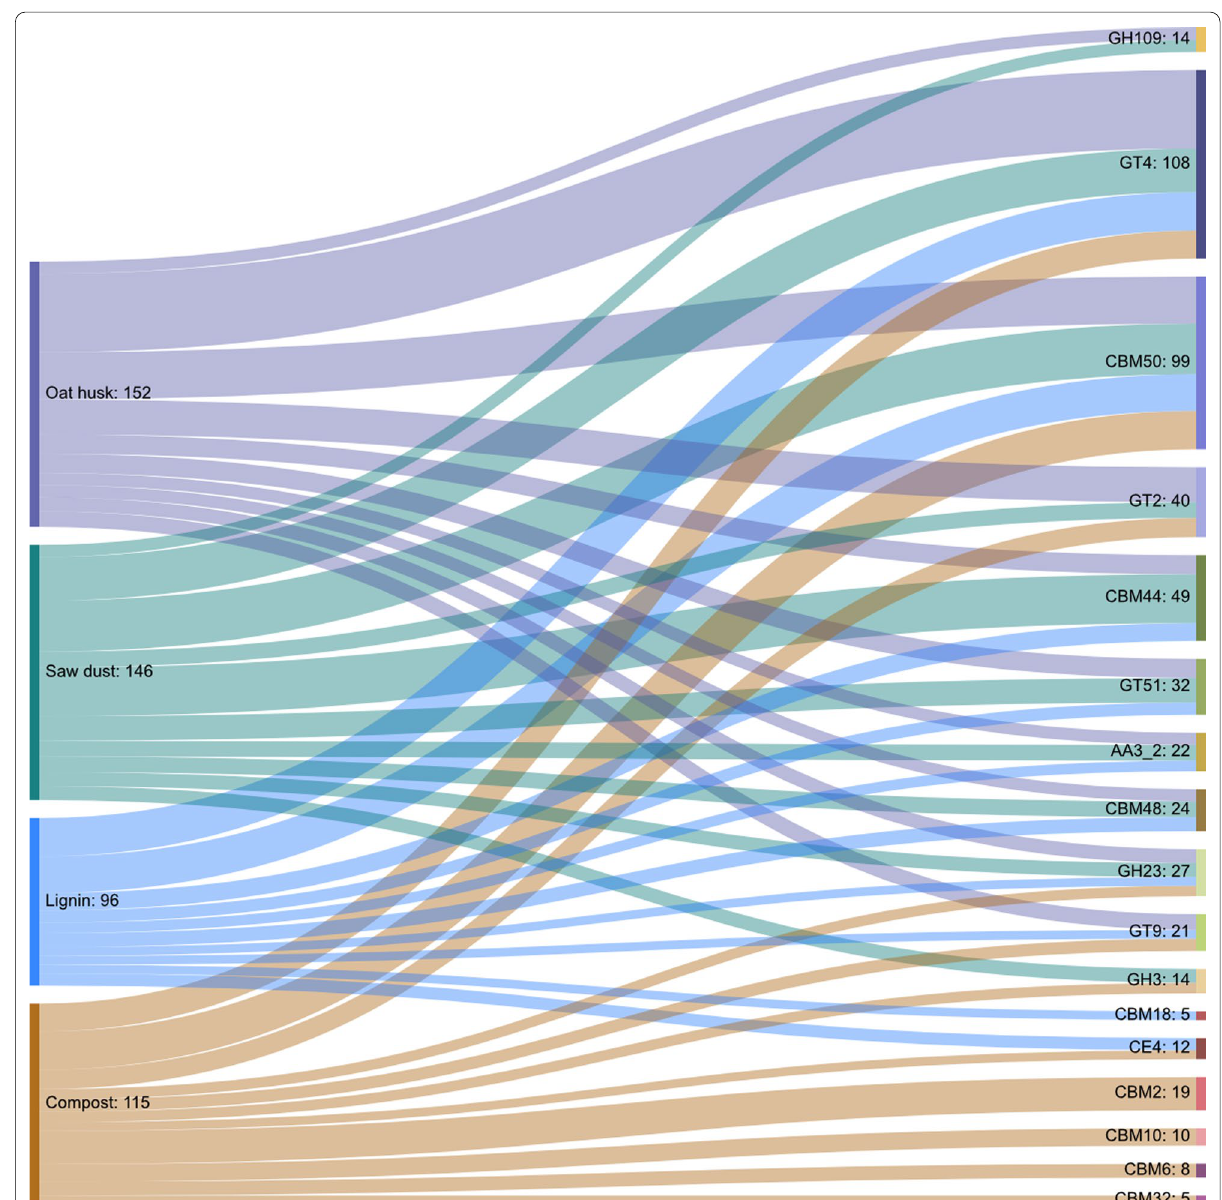
Fig. 5 Sankey diagram showing the distribution of hits belonging to the first 10 most abundant CAZyme families in each sample. The total count of hits in each CAZyme family across all the samples and in each sample were indicated after the data